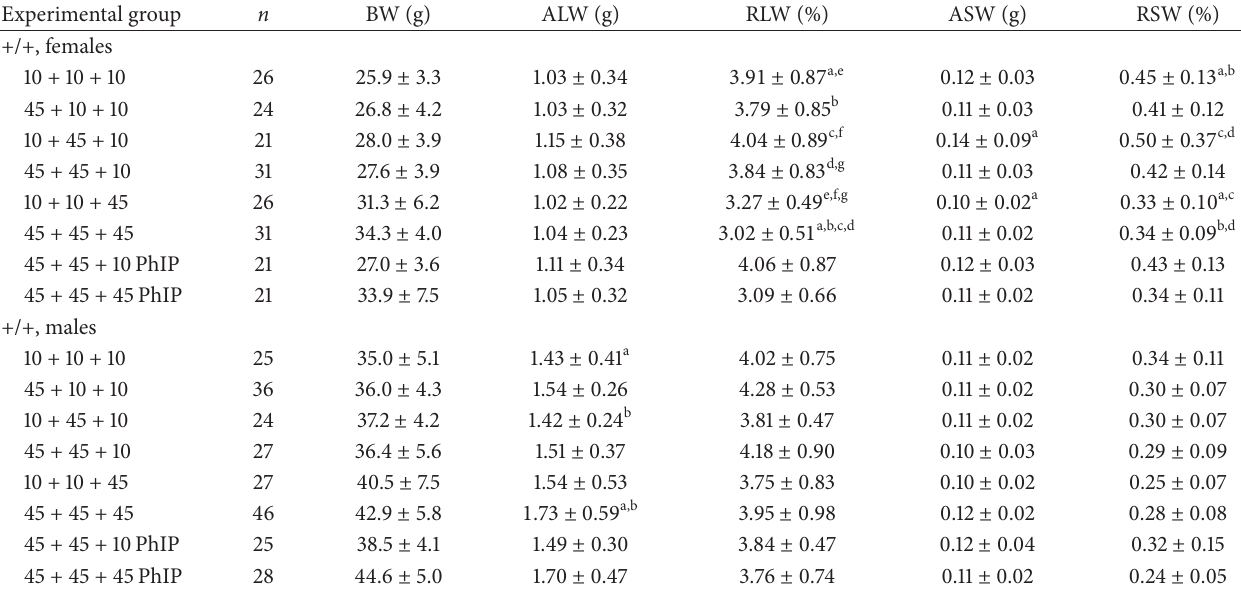
Table 2: Effects of exposure to a 45% fat diet during various periods of life on absolute liver weight (ALW), relative liver weight (RLW), absolute spleen weight (ASW), and relative spleen weight (RSW) in female and male wild-type mice terminated at 23 weeks of age (mean of individual mice in the group ±